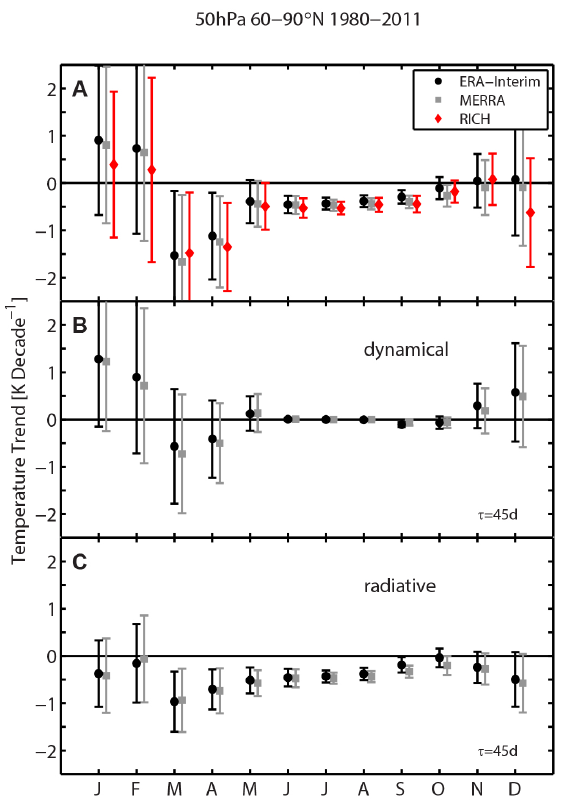
Fig. 1. Arctic temperature trends per decade at 50hPa for each month from ERA-Interim (black), MERRA (gray) and RICH ad- justed radiosonde observations (red) for the years 1980–2011. The figure shows the area-weighted average over 60–90 ◦ N. (A) Tem- perature trend. (B) Dynamical component of the trend. (C) Residual radiative component of the trend. Vertical bars show the 2 σ uncer- tainty.